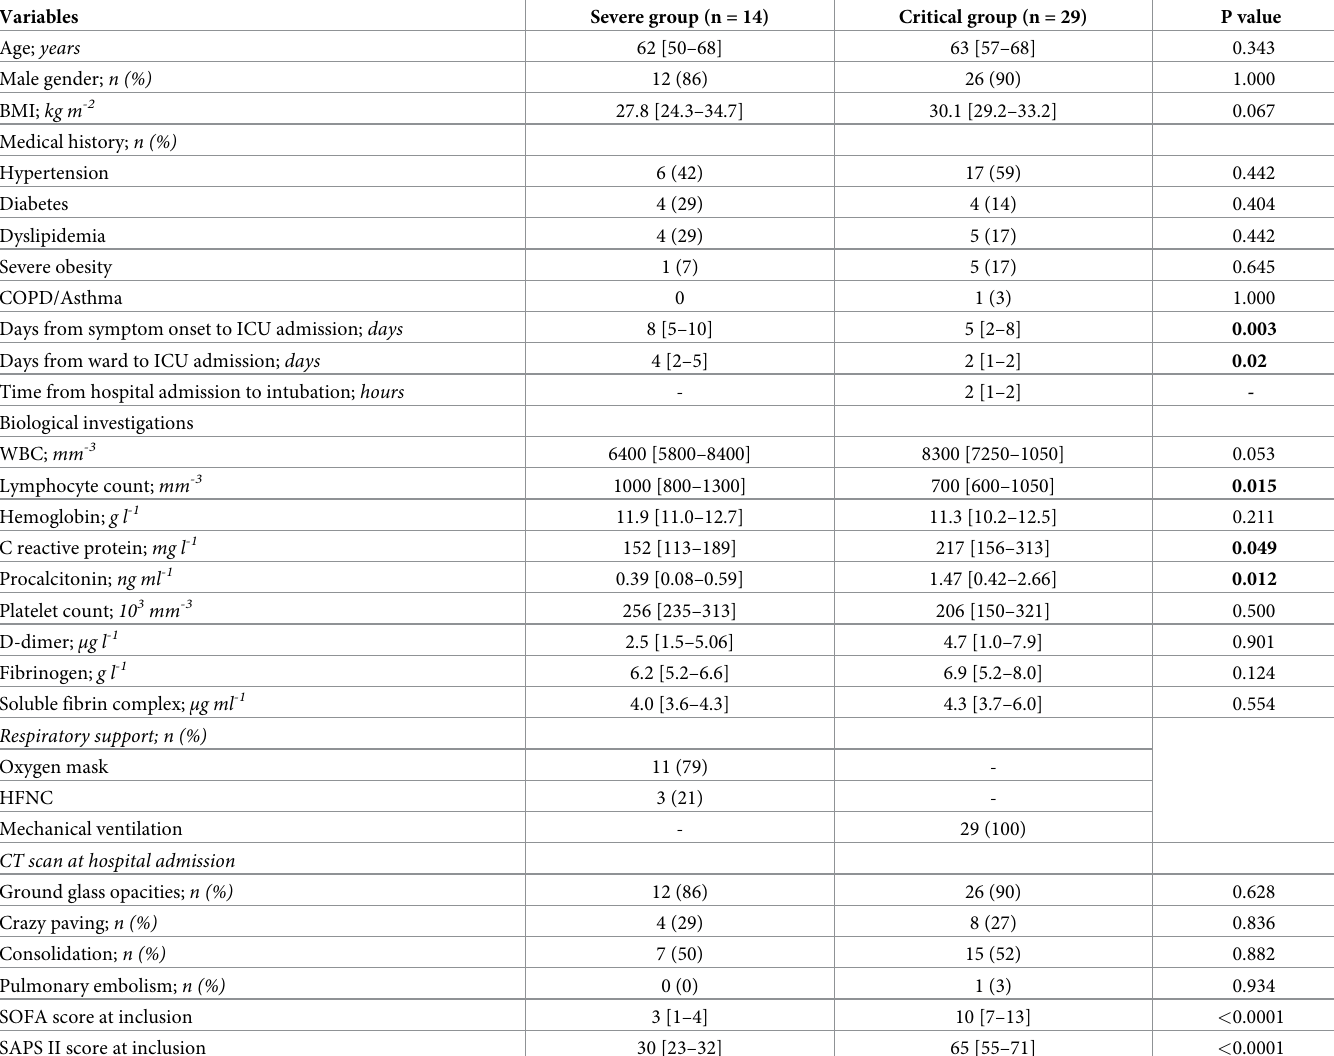
Table 1. Demographics between severe and critical